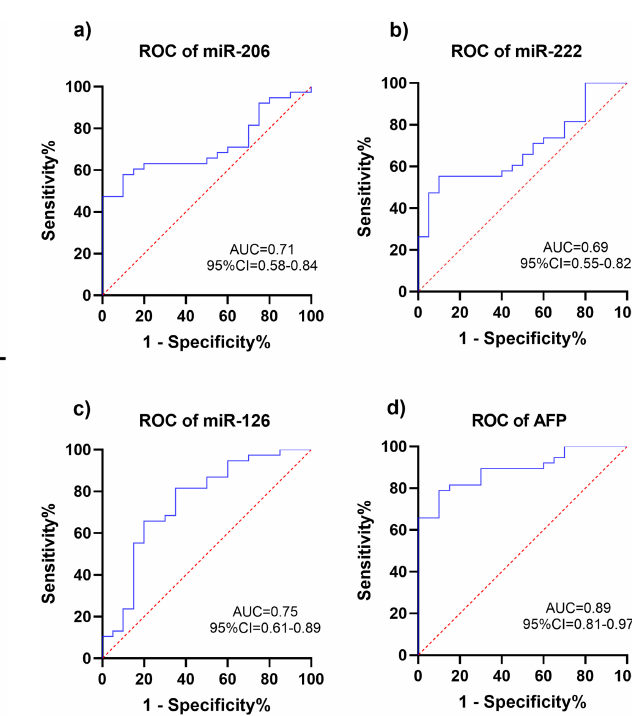
Figure 4. ROC analysis of the 3 miRNAs. (A) miR-206 in normal versus HCC, (B) miR-222 in normal versus HCC, (C) miR-126 in normal versus HCC, and (D) AFP in normal versus HCC. miRNA, microRNA; HCC, hepatocellular carcinoma; AFP, α -fetoprotein; ROC, receiver operating Figure 3. qRT-PCR analysis of miRNAs. The 2 upregulated miRNAs (A,B) and 1 downregulated miRNA (C). (D) Expression levels of AFP in HCC and the control groups. *Depict P < .05. qRT-PCR, quantitative reverse transcription-polymerase chain reaction; miRNA, microRNA; HCC, hepatocellular carcinoma; AFP, α -fetoprotein.